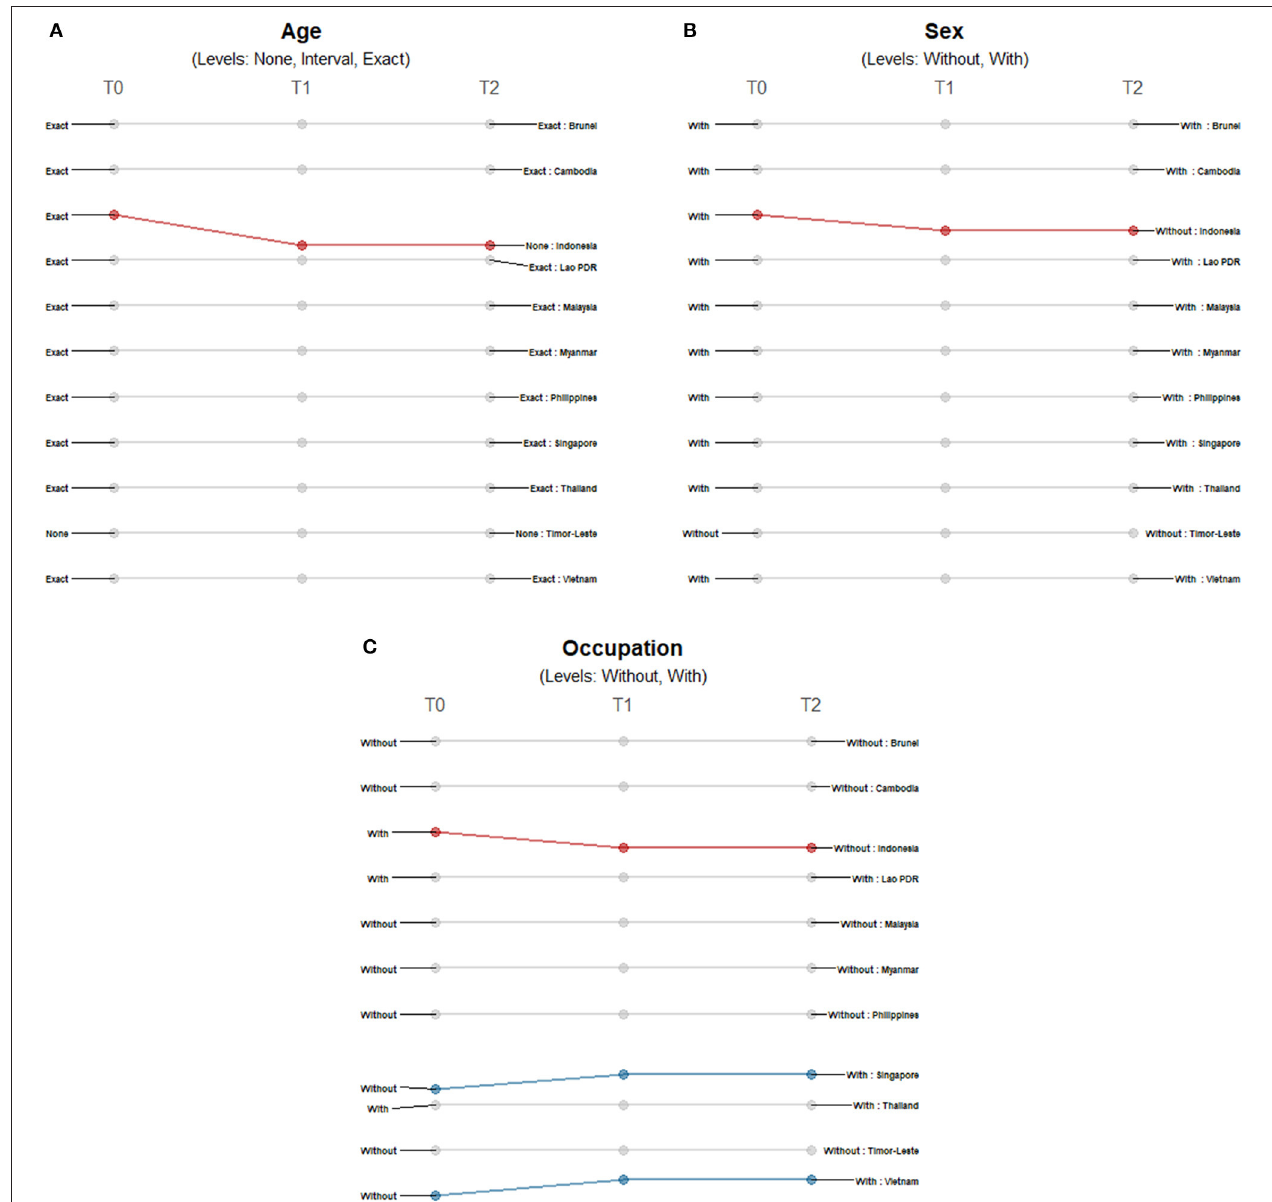
FIGURE 2 | Differences in the level of precision in reporting demographic data: (A) age, (B) sex, and (C) occupation over three timepoints. Only those countries with changes in the level of detail and precision of reporting are highlighted. Each country may shift reporting at any timepoint: at the first reporting of cases’ (T0), “first observed change in reporting” (T1), and “last observed change in reporting” (T2). Each country may report less precise data indicated by a decreasing slope (red) or more precise data indicated by an increasing slope (blue) consistently over time. Reporting may not be consistent across timepoints with shifts between different levels of precision (yellow) or reporting may not have changed at all during the study period (gray). The levels of precision are indicated for each epidemiological variable. Age has three levels while both sex and occupation are binary